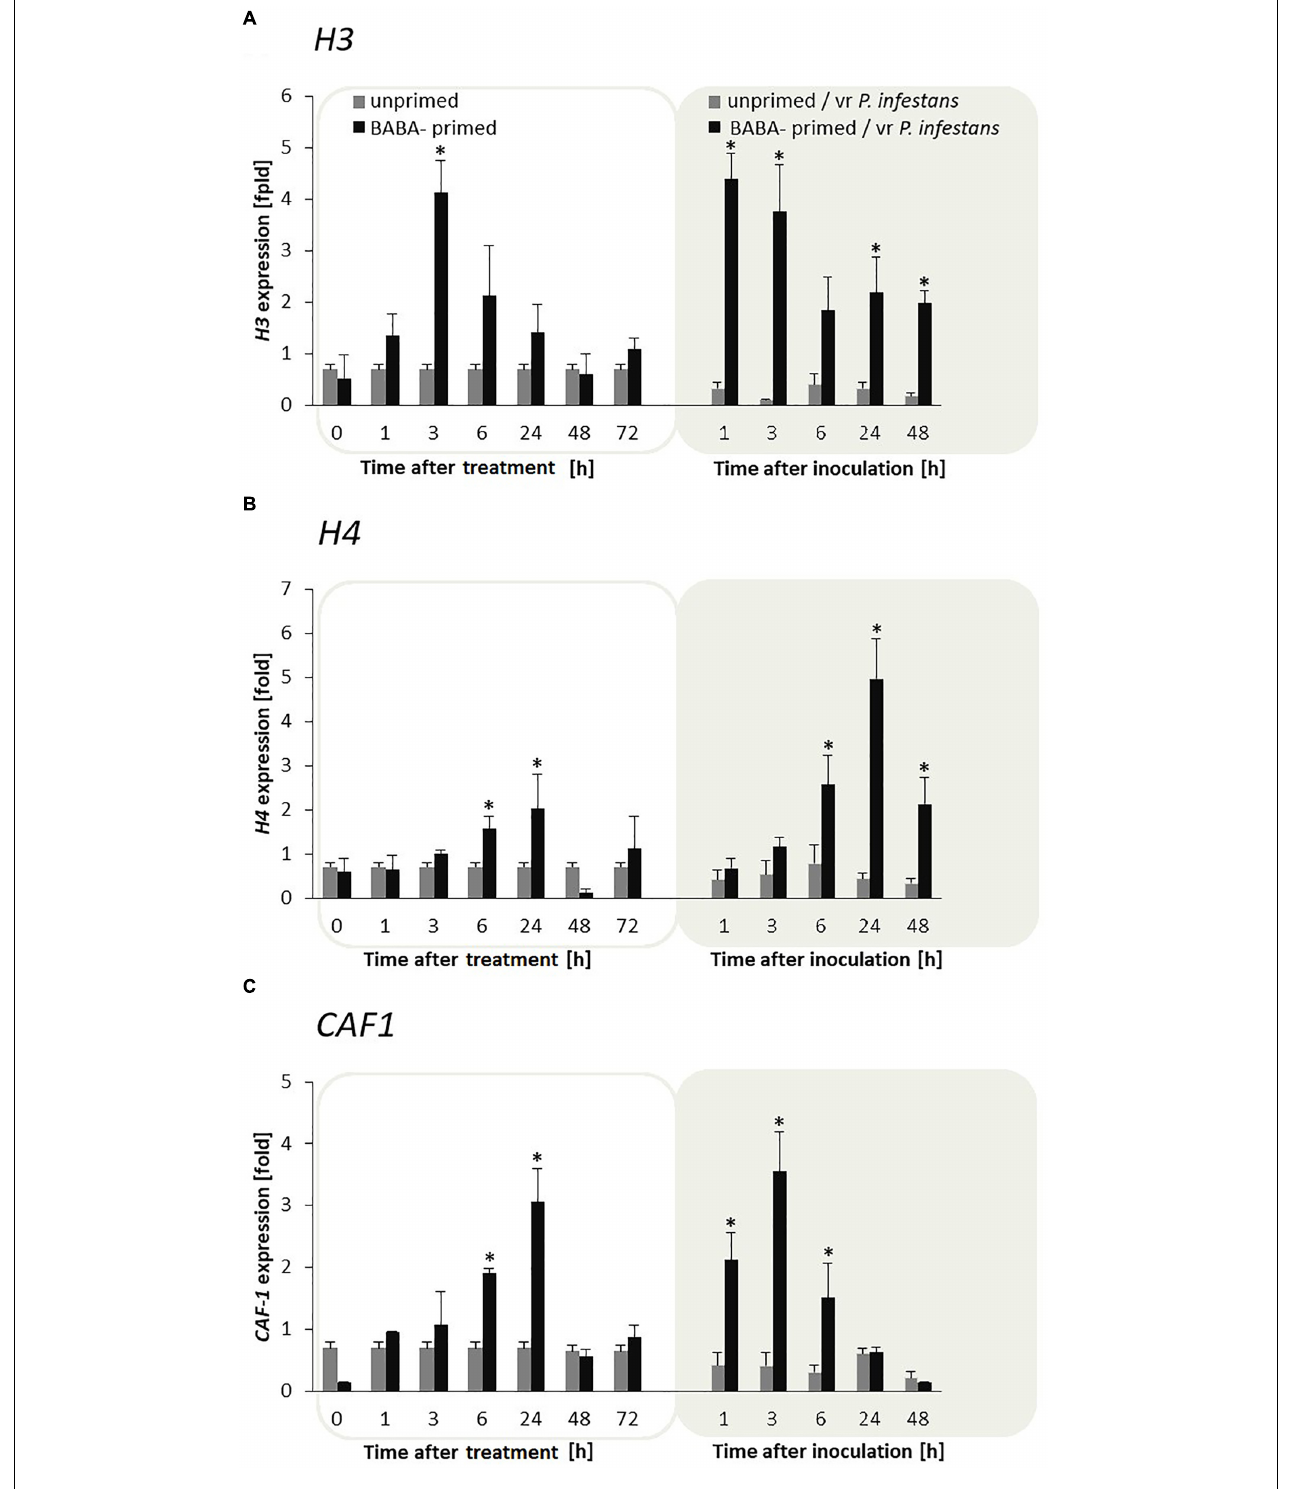
FIGURE 3 | Priming for defense is supported by enhanced expression of both H3, H4, and CAF-1 histone chaperon genes in F 0 potato progeny. The qRT-PCR analysis of H3 (A) , H4 (B) , and CAF1 (C) gene expression in BABA-primed leaves of potato plants followed by challenge inoculation with P. infestans (at 72 h after BABA treatment). Analyses were performed at 0–48 h after 5 mM BABA exposure (white background) and 1–48 hpi after challenge inoculation (gray background). Light columns refer to unprimed, while dark columns – to primed plants. Values represent means of data ± SD of at least three independent experiments. Asterisks indicate values that differ significantly from unprimed (water treated) or unprimed and P. infestans inoculated potato leaves at P < 0.05 ( ∗ ), respectively.